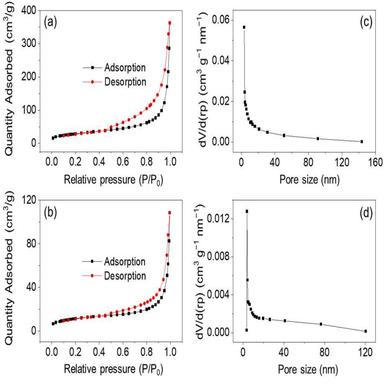
The N2 adsorption-desorption isotherms of (a) CoNi LDH NFs and (b) CoNi LDH NSs, and the plots of pore size distribution for (c) CoNi LDH NFs and (d) CoNi LDH NSs.